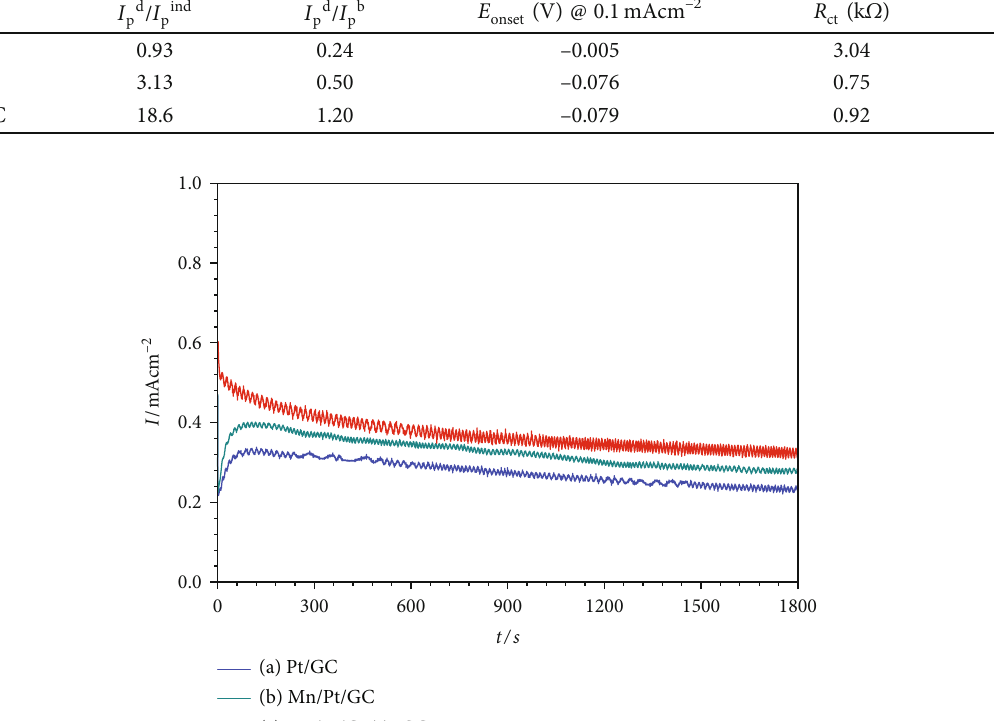
Table 3: Summary of the electrochemical data extracted from Figures 3, 5, and 6.